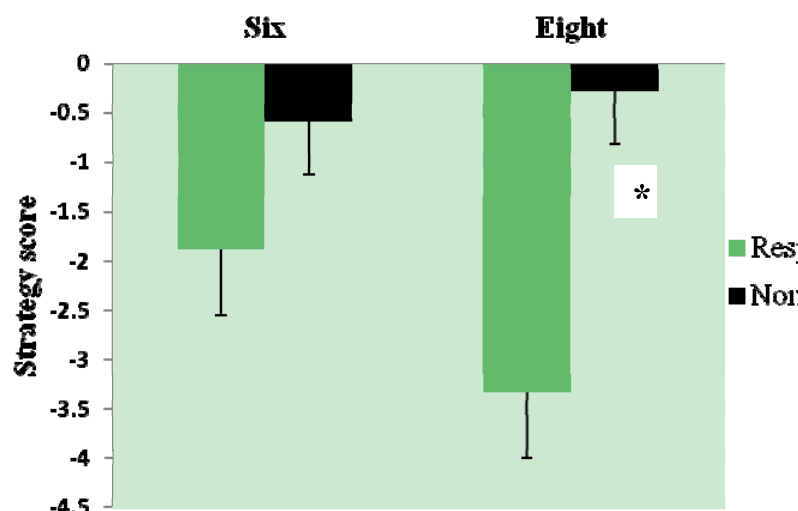
Figure 3. Change in strategy by ferritin response group; change (endpoint-baseline) in Spatial Working Memory strategy score for six- and eight-box problems in ferritin responders ( n = 17) and non-responders ( n = 26). A lower score and larger negative change indicate better strategy. Main effect of responder group, p = 0.007; * p < 0.05 between-group comparison for eight-box